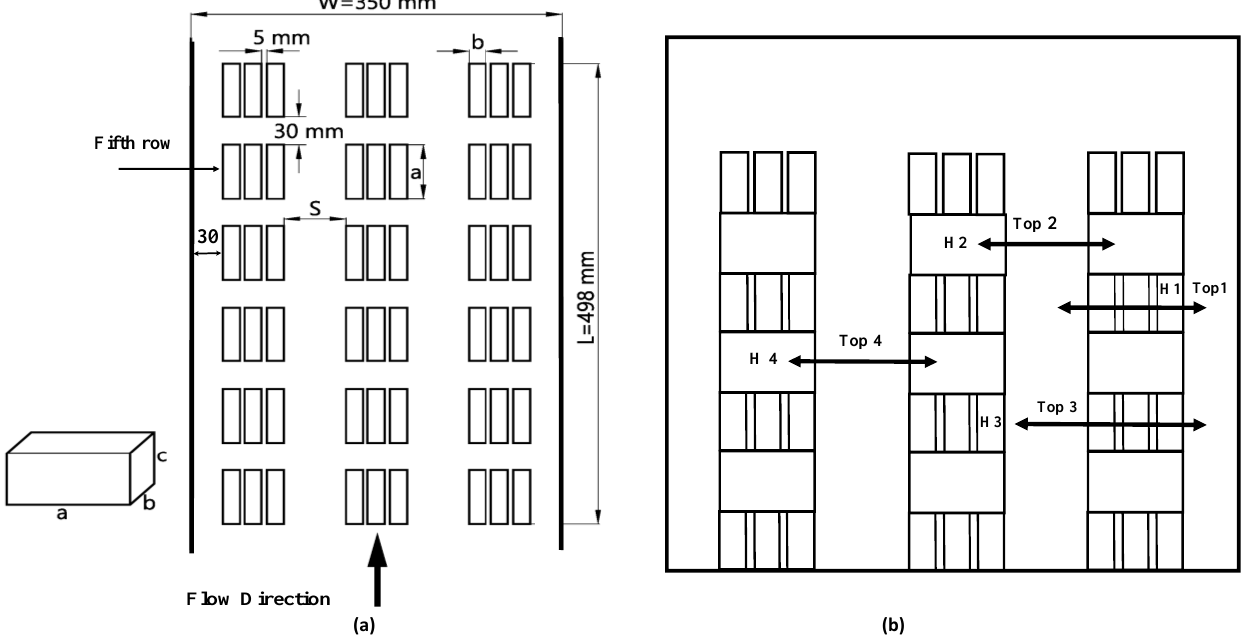
Figure 2. Setting 2 complete details: ( a ) Top view of the first layer, ( b ) Sectional view in the fifth row [14].